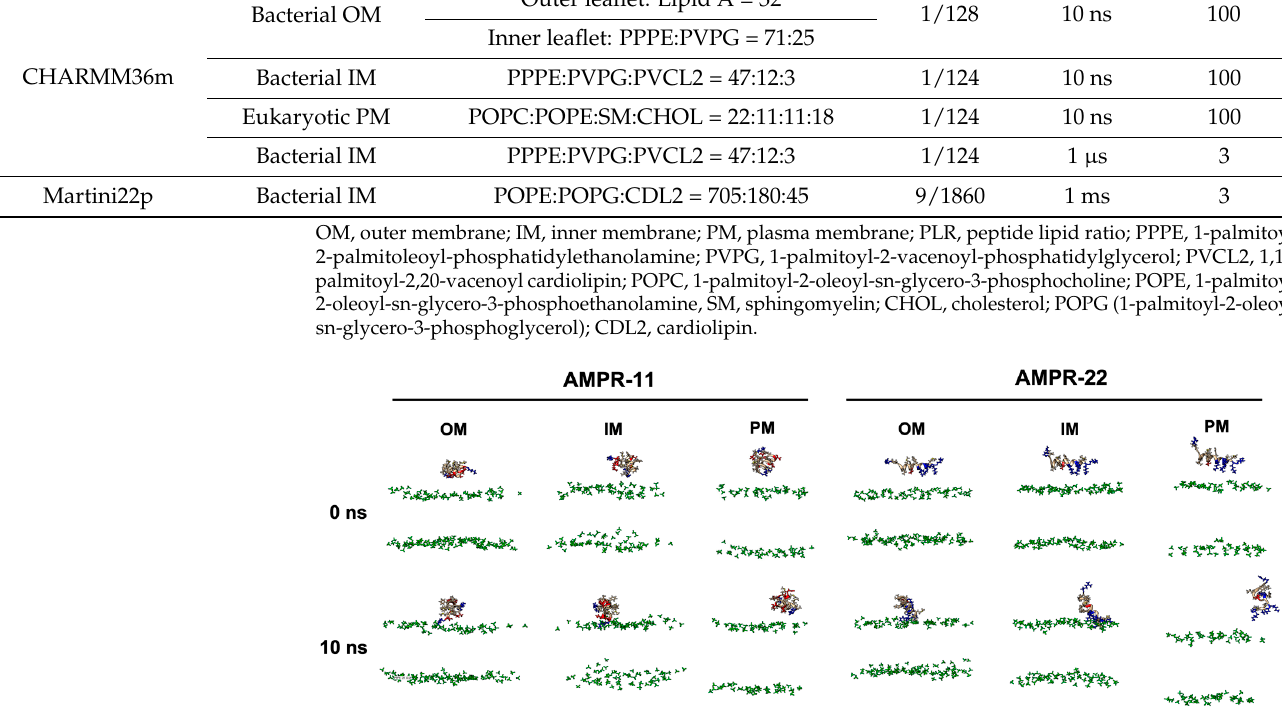
Figure 3. Hydrogen bond formation between AMPR-11 or AMPR22 and model membranes. ( A ) The number of hydrogen bonds of AMPR-11 or AMPR-22 with each model membrane was calculated